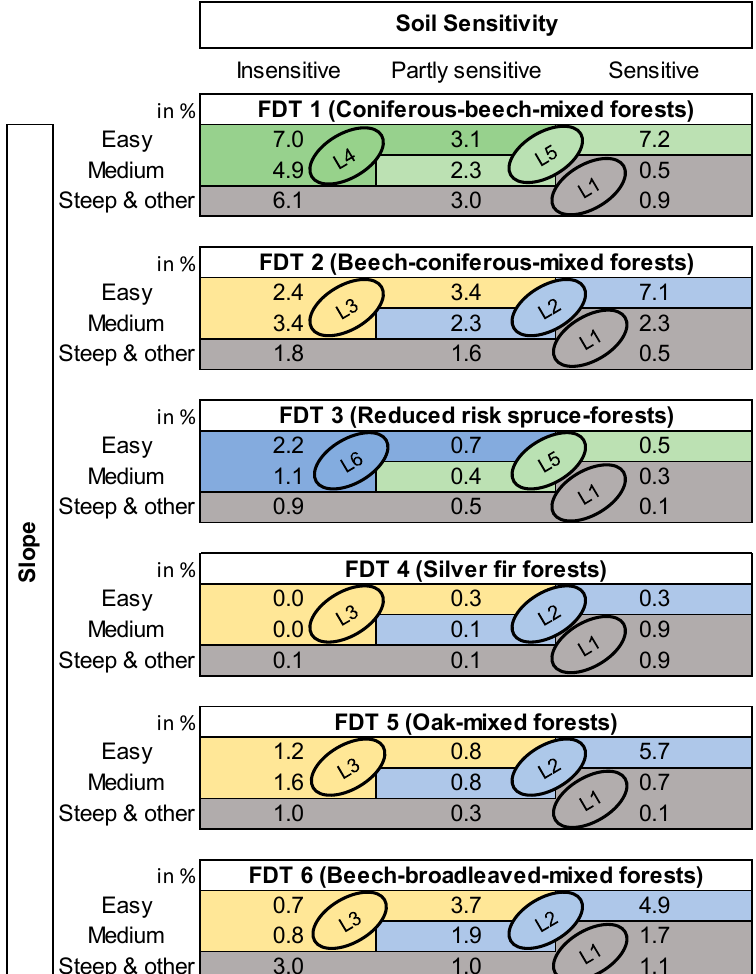
Figure 6. Proportion (in %, relative to the total area) of the application area of different logging operations (L) regarding the Forest Development Types (FDTs), where any insensitive soil class indicates that traffic is possible (ground ‐ based forest operations on skid trails); a partly sensitive soil class indicates that low traffic is possible (ground ‐ based forest operations on tractor roads); and a sensitive class indicates that traffic is not possible (roadways/cable yarder forest operations) (c.f. Figure 3). L1 to L6 as described in Table 6.